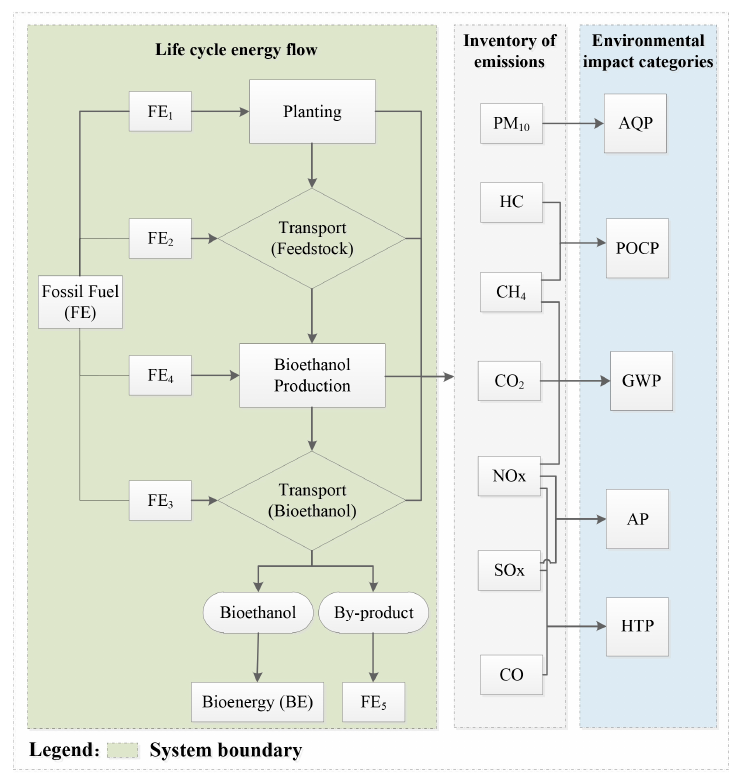
Figure 1. The system boundary, energy flow, emission inventory and environmental impact categories of this study.